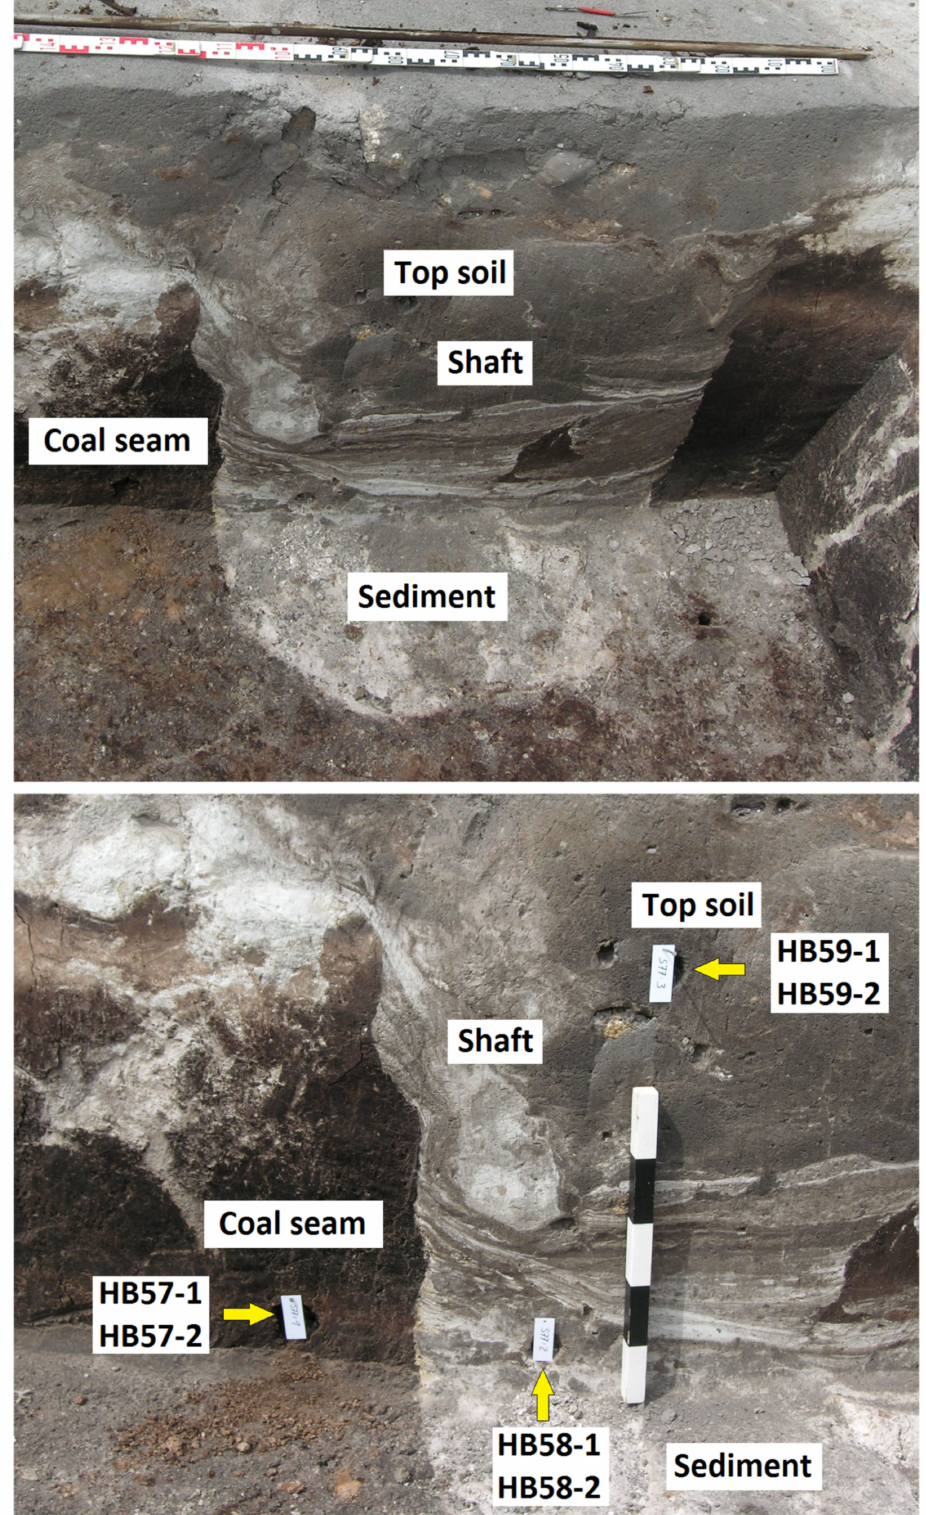
Figure 1. Sampling sites. The picture shows the three different structures of an exploratory shaft of an ancient lignite mining site. Two samples were taken from each layer (topsoil, coal seam, and sediment). The depth and width can be estimated using the reference bars. The black and white bar is 50 cm long in total (picture below), and the other has 5 cm per section (picture